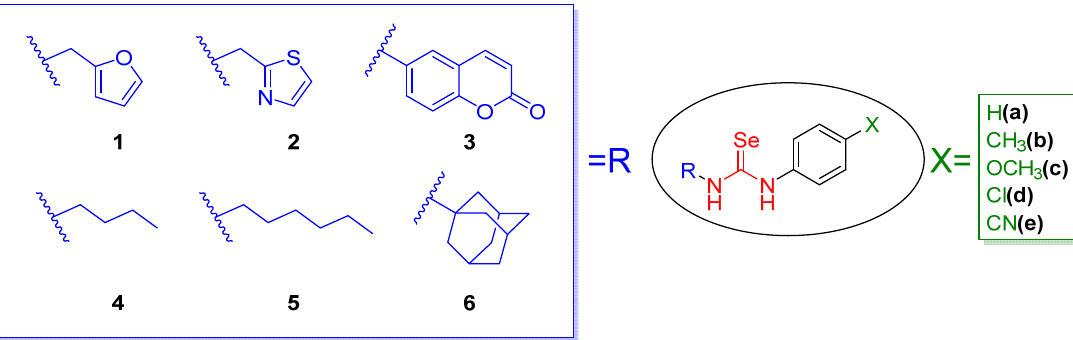
Figure 1. Structural design of selenoureas presented in this work. The cytotoxic activity of these novel selenoureas was screened in vitro at two doses (10 and 50 µM) against a panel of cancer cell lines derived from breast (MCF-7), lung (HTB-54), and colon (HT-29), using a colorimetric assay of 3-(4,5-dimethyl-2-thiazolyl)- 2,5-diphenyl-2 H -tetrazolium bromide (MTT). Ten of these selenoureas were chosen